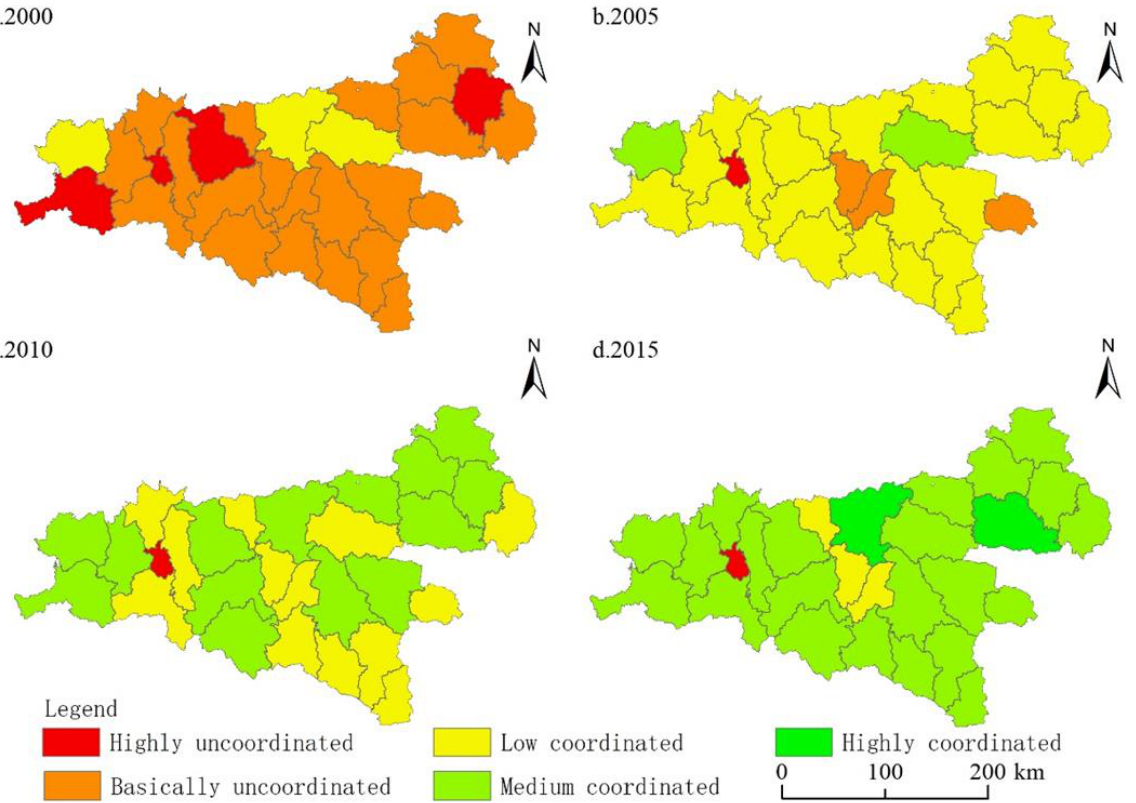
Figure 6. Ecological and socioeconomic coupling coordination degree of various counties in the Qinba Mountains in ( a ) 2000, ( b ) 2005, ( c ) 2010, and ( d ) 2015.